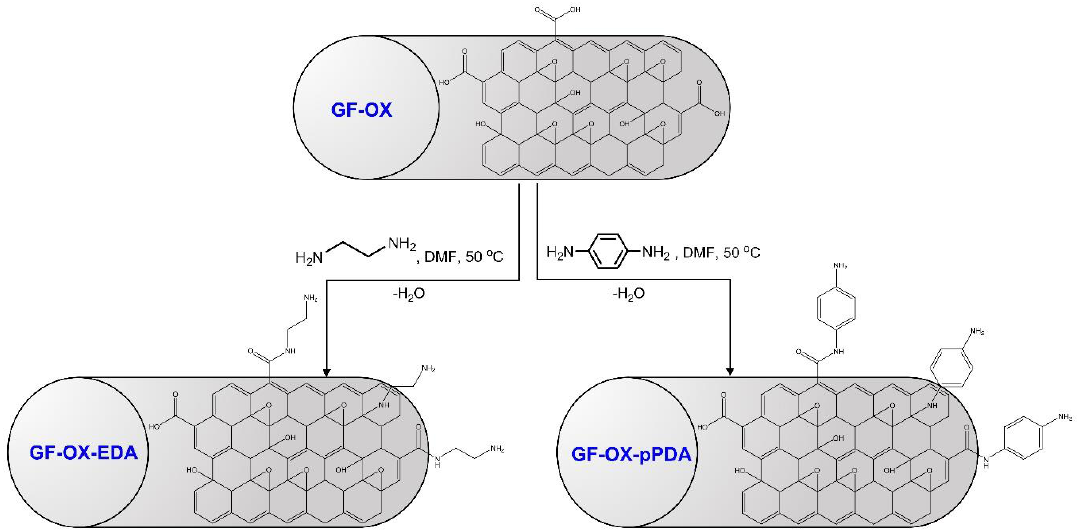
Figure 3. Schematic view of one-step modification (Method A) of electrochemically oxidized graphite felt (GF-OX) with ethylenediamine and p -phenylenediamine. For comparison reasons, the N -(2-aminoethyl)carbamoyl and 2-aminoethylamino or N -(4- aminophenyl)carbamoyl and 2-aminophenylamino moieties were introduced onto the GF-OX surface by this two-step procedure as well (Method B).